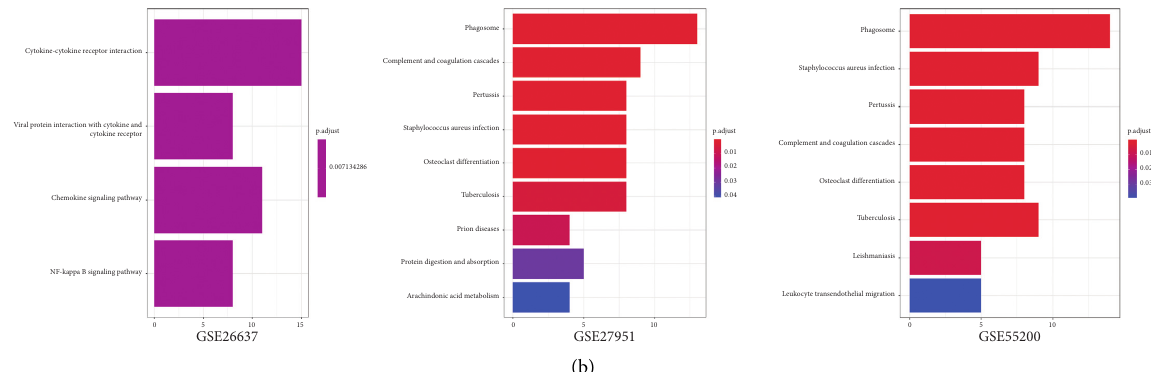
Figure 3: Functional annotation of DEGs from each dataset. (a) The cell component, molecular function, and biological process of DEGs annotated in gene ontology. Counts: the number of enriched DEGs. Gene Ratio: the number of expression genes in the GO category to that of the annotated genes. (b) The enriched KEGG pathways of DEGs from each dataset.